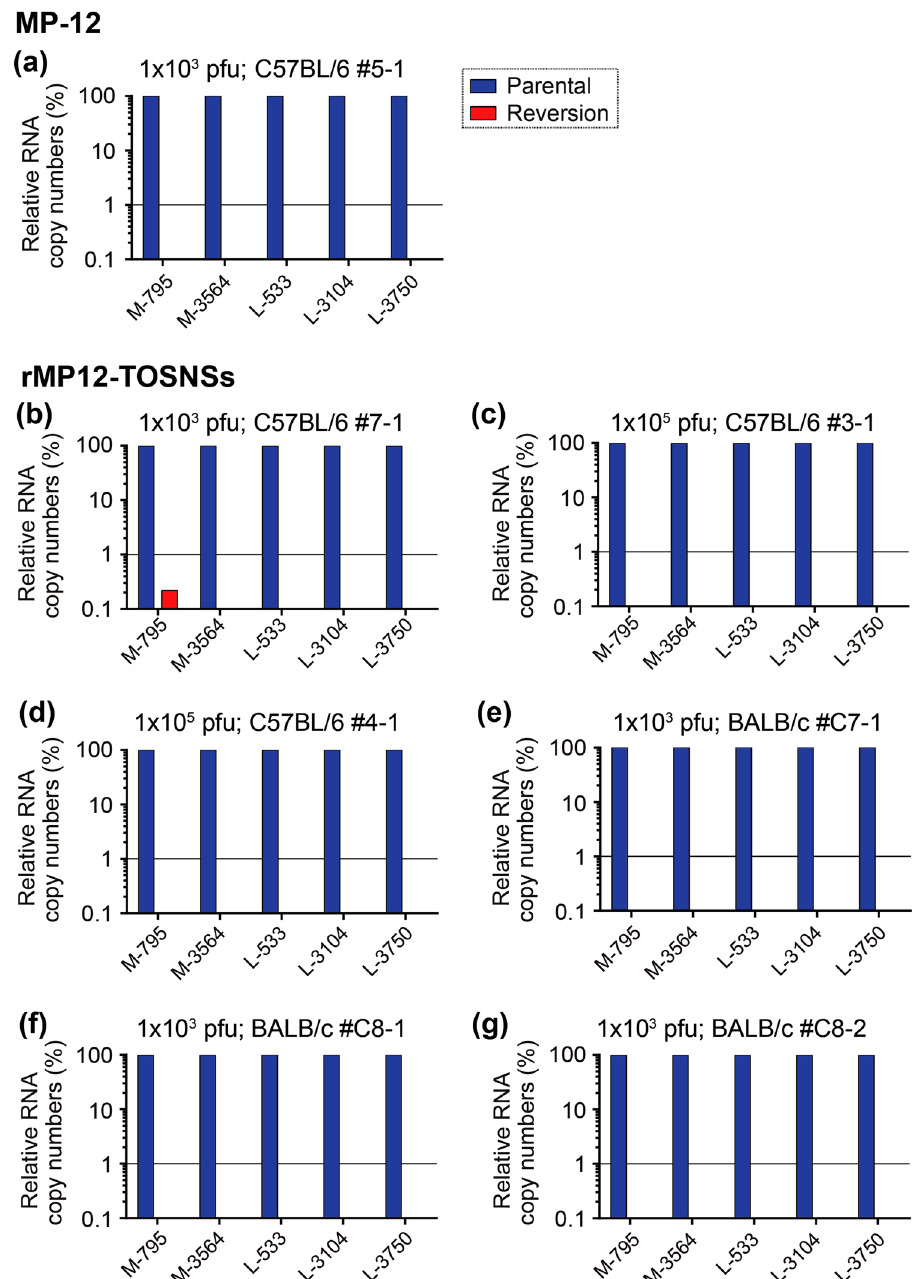
Fig. 6 Detection of reversion mutations in MP-12 and rMP12-TOSNSs in brains of mice. The ddPCR to detect reversion mutants at M-795, M- 3564, L-533, L-3104, and L-3750 was performed using total RNA samples from mouse brains reported by Indran et al. 24 BALB/c ( e – g ) or